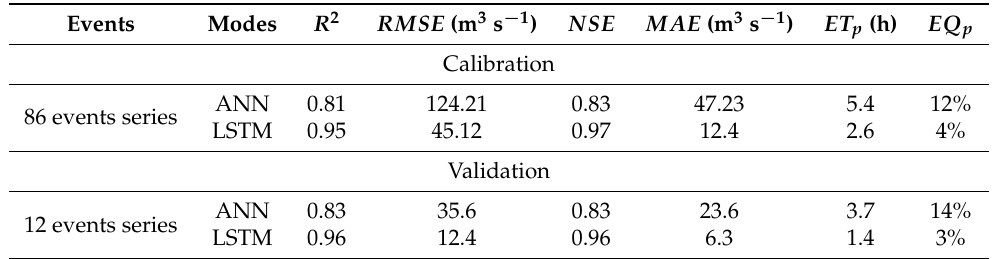
Table 2. Comparison of performances of ANN and LSTM models for runoff prediction (lead time = 1 h) at calibration (86 flood events) and validation (12 flood events)